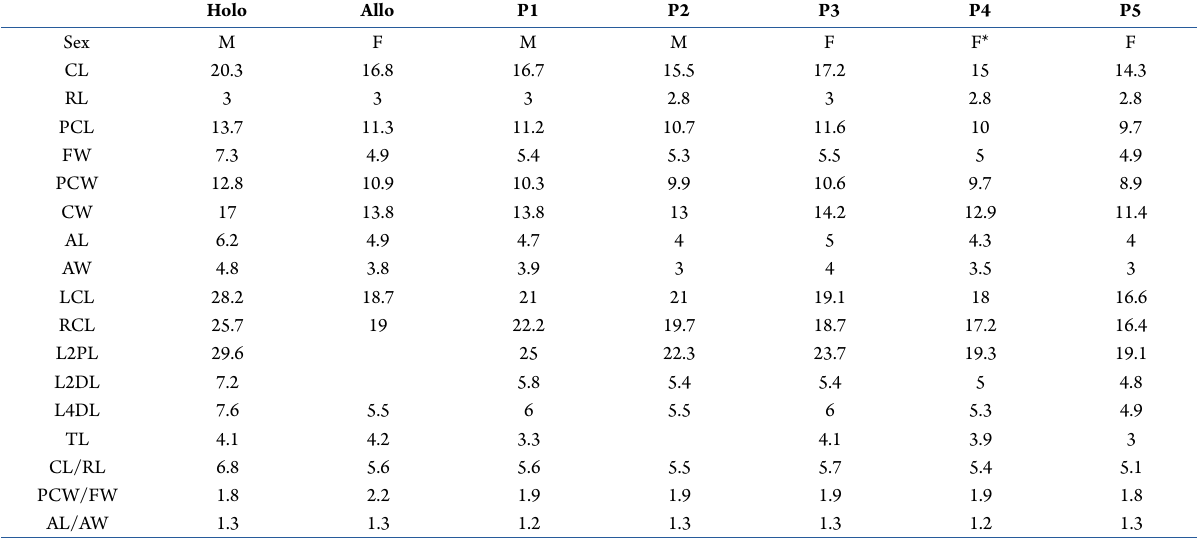
Table 1. Morphometry of Aegla chilota n. sp. type series from River Incopulli at 43º06’02” S; 73º41’47” W. Measurements in mm. M= male; F= female; F*= ovigerous female; Holo= holotype; Allo = allotype; P1 to P5 = paratypes. CL, carapace length between rostral apex and posterior margin of cephalothorax; RL, rostral length between rostral tip and transversal line tangent to deepest point of orbits; PCL, precervical length between rostral tip and midpoint of cervical groove; FW, frontal width between tips of anterolateral angles of carapace; PCW, maximum precervical width across third hepatic lobes; CW, maximum carapace width; AL, areola length along carapace dorsal midline; AW, areola maximum width; LCL, left cheliped length; RCL, right cheliped length; L2PL, left second pereiopod length; L2DL, dactylar length of left second pereiopod; L4DL, dactylar length of left fourth pereiopod; TL, telson